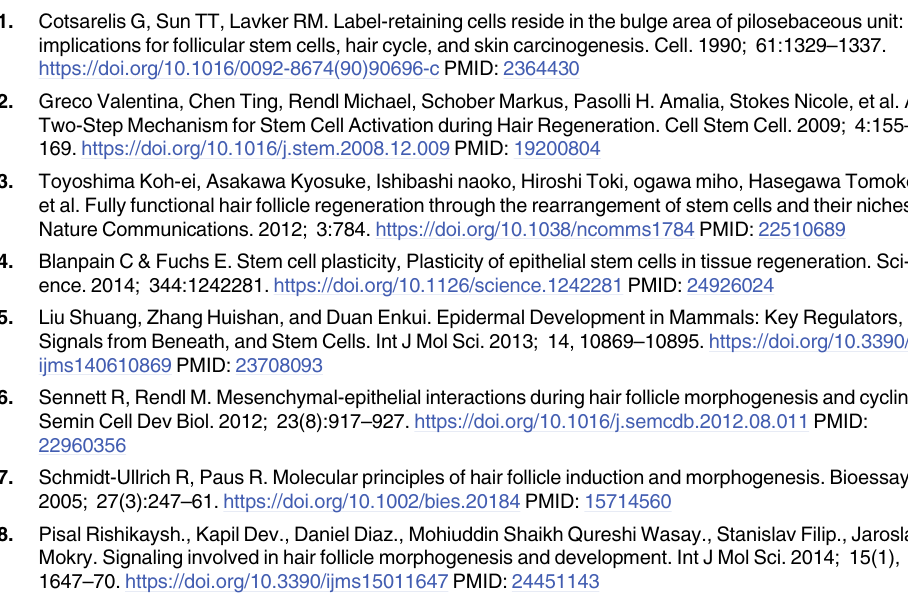
S2 Table. List of reported HFSC signature genes and reported cell cycle genes identified from the RNA-Seq